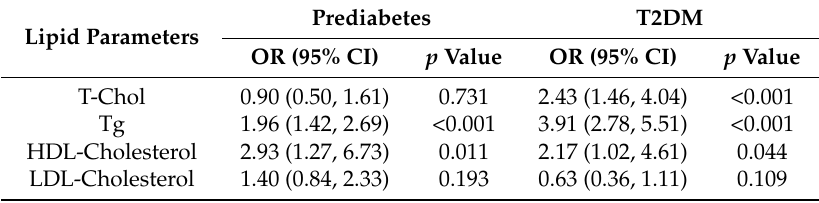
Table 2. Odds ratio (OR) with 95% CI of different lipid parameters for having risk of T2DM and prediabetes. Prediabetes T2DM Lipid Parameters OR (95% CI)